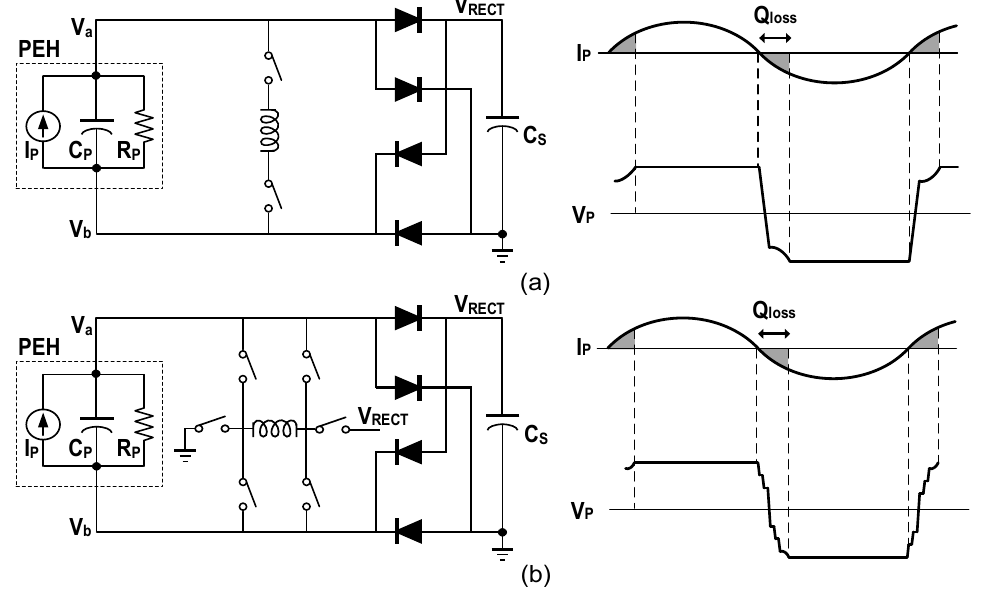
Figure 12. Interface circuit structures and I P , V P waveforms diagrams of ( a ) the SSHI, ( b ) the multi- step flipping SSHI, respectively.